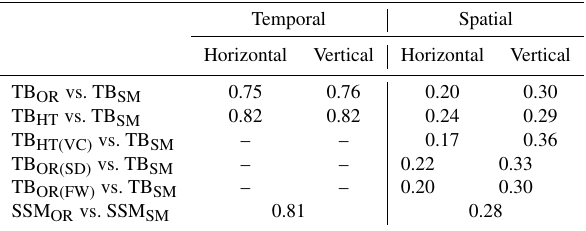
Table 4. Mean temporal and spatial correlations for SSM (Polcher et al., 2016) and the horizontal and vertical polarizations of TBs over the Iberian Peninsula from 2010 to